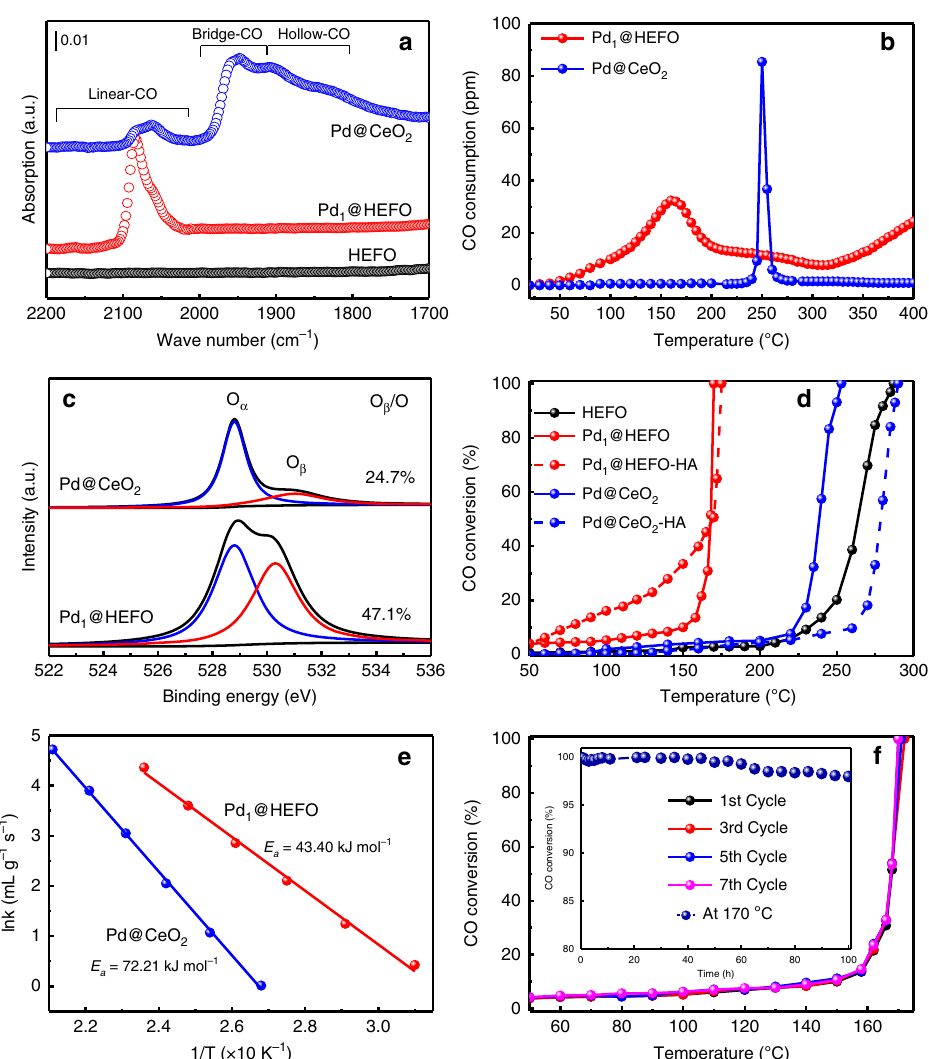
Fig. 5 Catalytic performances of CO oxidation for Pd 1 @HEFO and Pd@CeO 2 . a CO-DRIFTS results of HEFO, Pd 1 @HEFO, and Pd@CeO 2 . b CO-TPR of Pd 1 @HEFO and Pd@CeO 2 . c XPS pro fi les of O 1 s for Pd 1 @HEFO and Pd@CeO 2 . d CO oxidation of catalytic performance of different catalysts before (solid lines) and after (dashed lines) hydrothermal treatments. Reaction conditions: A catalyst loading of 20 mg, and 1 vol% CO balance in air at a gas-hourly space velocity of 40,000 mL gcat − 1 h − 1 . e Arrhenius plots of Pd 1 @HEFO and Pd@CeO 2 . f the cycled measurement of CO oxidation over Pd 1 @HEFO and its stability at 170 °C (inset). Source data are provided as a Source data